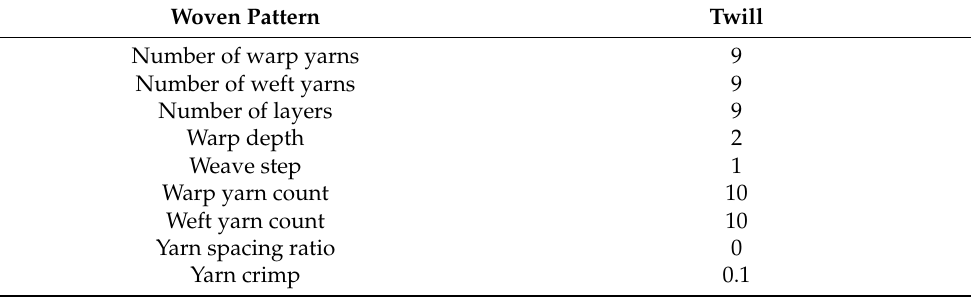
Table 3. Parameters for microstructure generation of fabric.